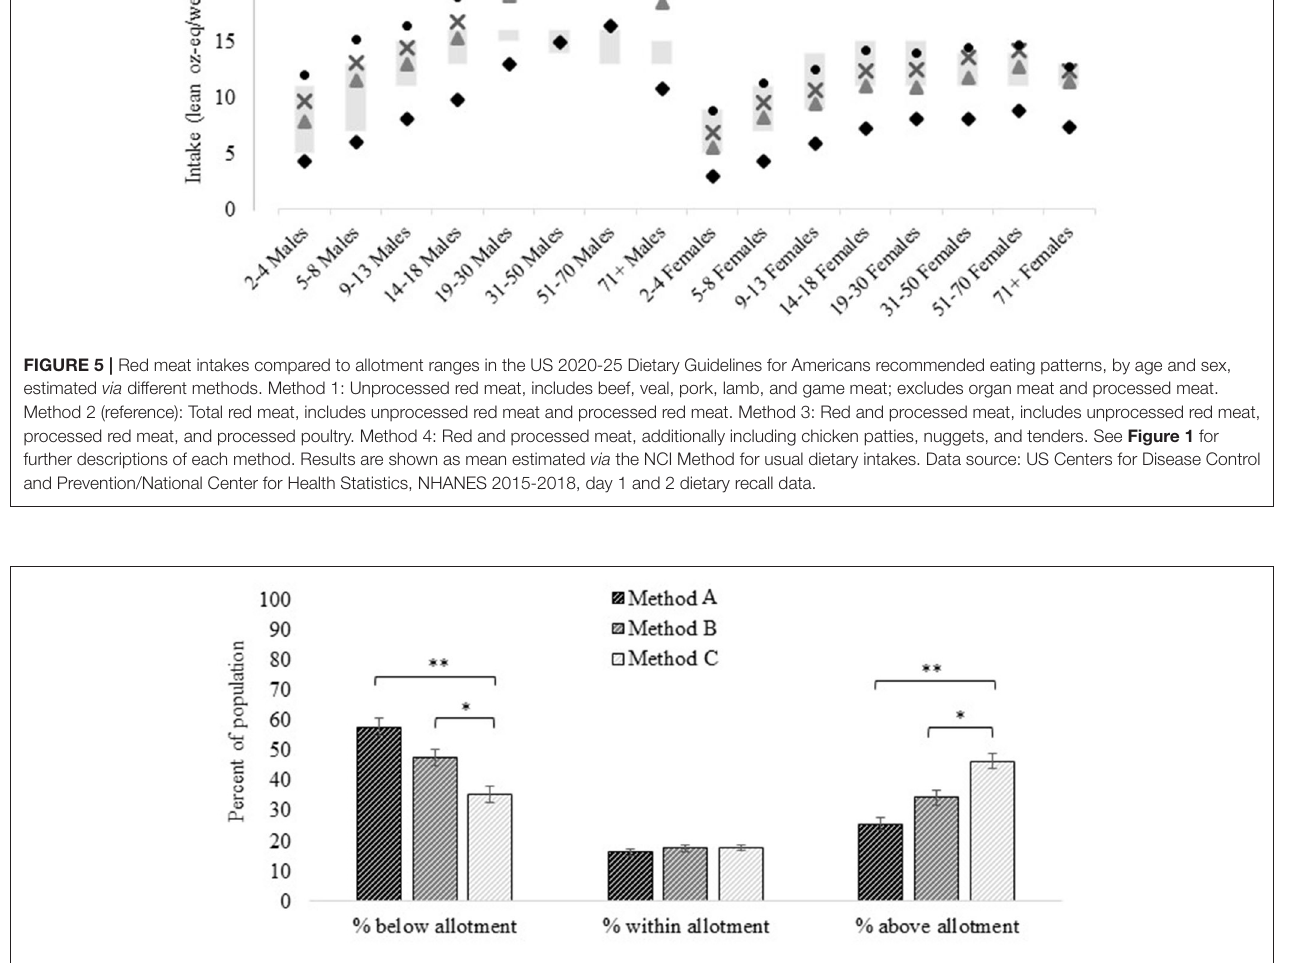
FIGURE 6 | Poultry intakes compared to allotment ranges in the US 2020–25 Dietary Guidelines for Americans recommended eating patterns estimated via different methods. Method A: Unprocessed poultry, includes chicken, turkey, Cornish hens, duck, goose, quail, and pheasant (game birds); excludes organ meat and cured meat; additionally excludes chicken patties, nuggets, and tenders. Method B: Unprocessed poultry, includes chicken, turkey, Cornish hens, duck, goose, quail, and pheasant (game birds); excludes organ meat and cured meat and includes chicken patties, nuggets, and tenders. Method C (reference): Total poultry, includes unprocessed poultry, processed poultry, and chicken patties, nuggets, and tenders. See Figure 1 for further descriptions of each method. Results are shown as mean ± SEM within each percentile estimated via the NCI Method for usual dietary intakes. *Difference from Method 1 estimate (effect size) is ≥ 10%; **difference from Method 1 estimate is ≥ 20%. Data source: US Centers for Disease Control and Prevention/National Center for Health Statistics, NHANES 2015-2018, day 1 and 2 dietary recall